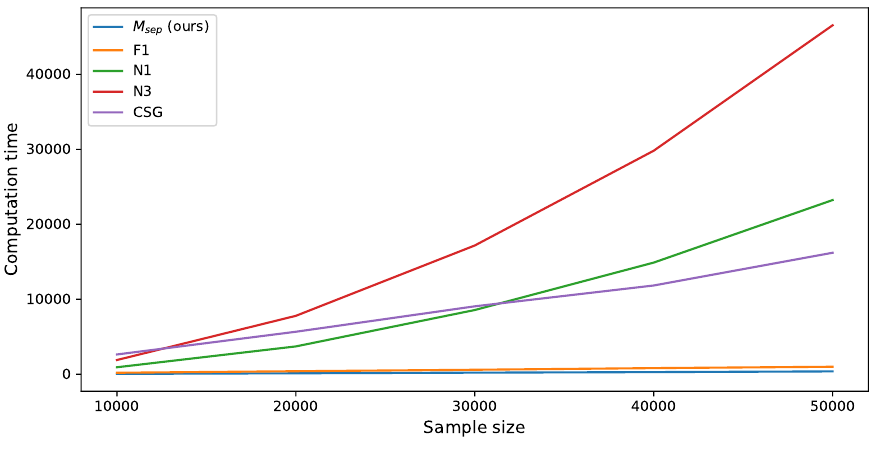
Figure 3. Sample size vs. computation time (CIFAR10). Table 5. Sample size vs. computation time (CIFAR10) in detail (the values in the table represent seconds). Sample